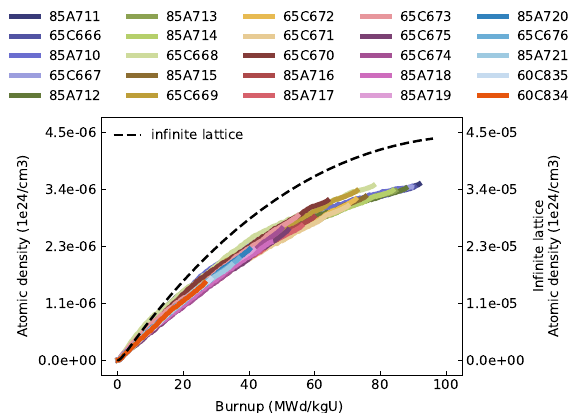
Figure 5. Axially averaged atomic densities of 239 Pu calculated for all fuel assemblies with initial zero bur- nup (left axis). The calculated values are compared with atomic densities from the infinite lattice approxi- mation (right axis).